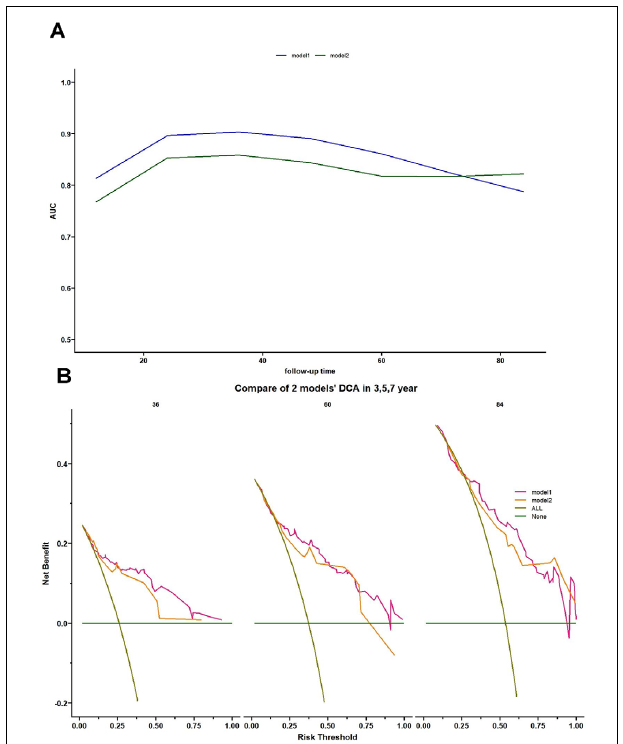
FIGURE 4 | Time-dependent AUC and decision curve analysis (DCA) for model 1 and model 2. (A) Time-dependent AUC plot showing how the AUCs of model 1 and model 2 changed with follow-up time. (B) DCA of model 1 and model 2 for 3-, 5-, and 7-year predictions. The brown line represents the assumption that all PD-RBD patients have MCI. DCA showed the following: (1) all patients would benefit from model 1 and model 2 for 3-year prediction; (2) for 5-year prediction, patients at risk threshold < 0.75 would benefit from model 2, while patients at almost all risk thresholds would gain a positive net benefit in model 1; and (3) using model 1 and model 2 benefits patients more than the treat-all scheme or the treat-none scheme at almost all risk thresholds.